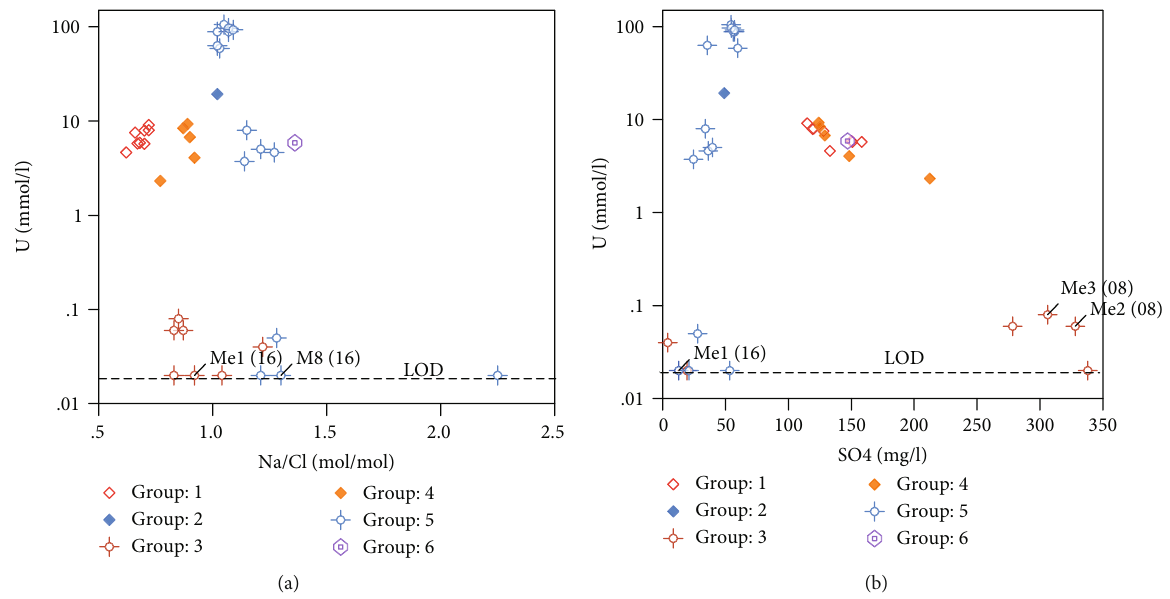
Figure 5: Crossplots of U(VI) and Na/Cl values in the groundwater of the Lower Yarmouk